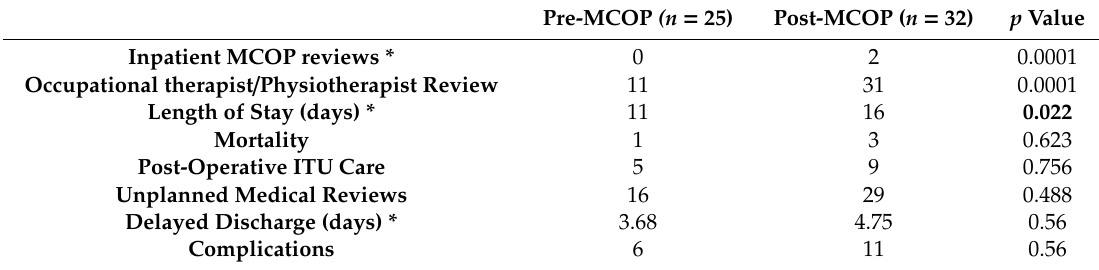
Table 2. Post-operative outcomes.